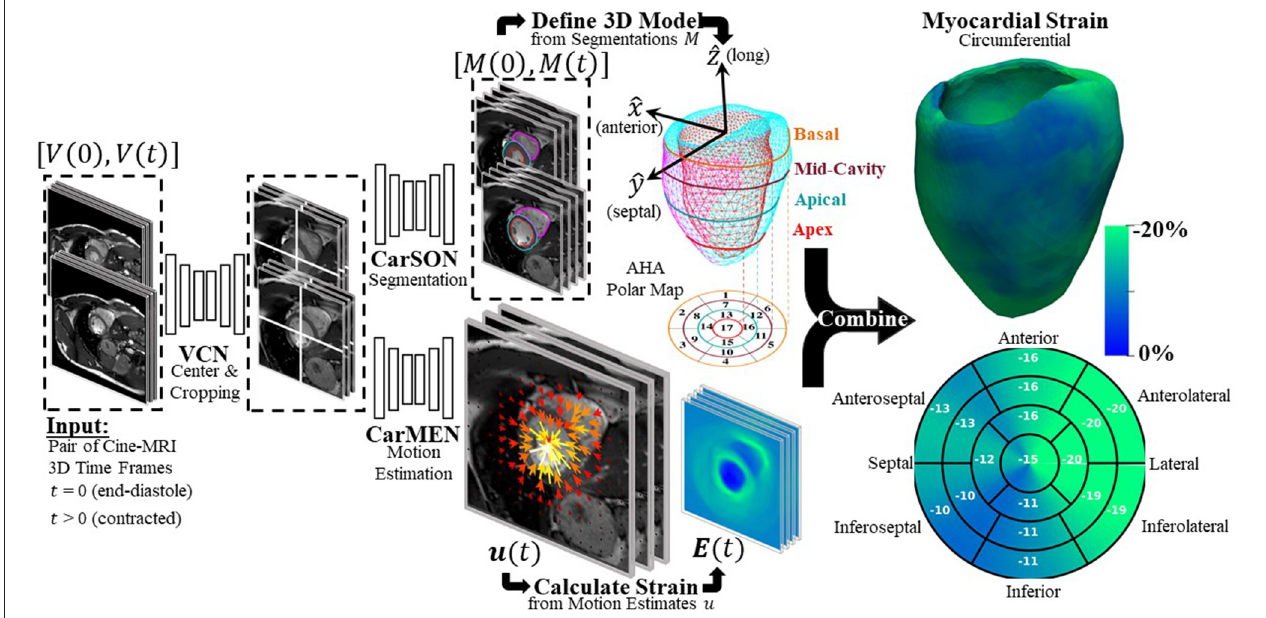
FIGURE 1 | Overview of proposed DeepStrain workflow. VCN centers and crops the input pair of cine-MRI frames. Tissue labels generated by CarSON are used to build an anatomical model. Motion estimates derived from CarMEN are used to calculate strain measures, and these estimates are combined with the anatomical model to enable global and regional strain